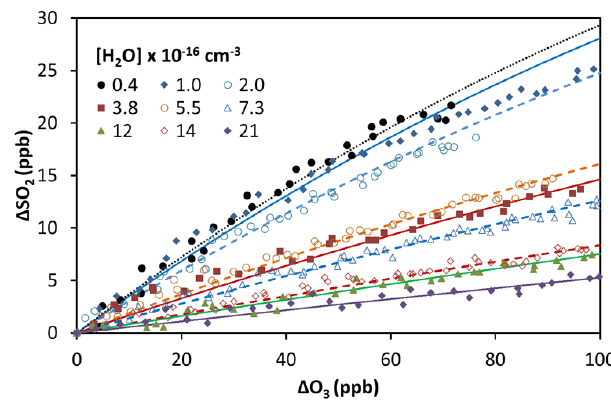
Figure 2. Cumulative consumption of SO 2 and O 3 , (cid:49) SO 2 ver- sus (cid:49) O 3 , for the ozonolysis of isoprene in the presence of SO 2 at a range of water vapour concentrations, from 4 × 10 15 to 2.1 × 10 17 cm − 3 . Symbols are experimental data corrected for chamber dilution. Lines are smoothed fits to the experimental